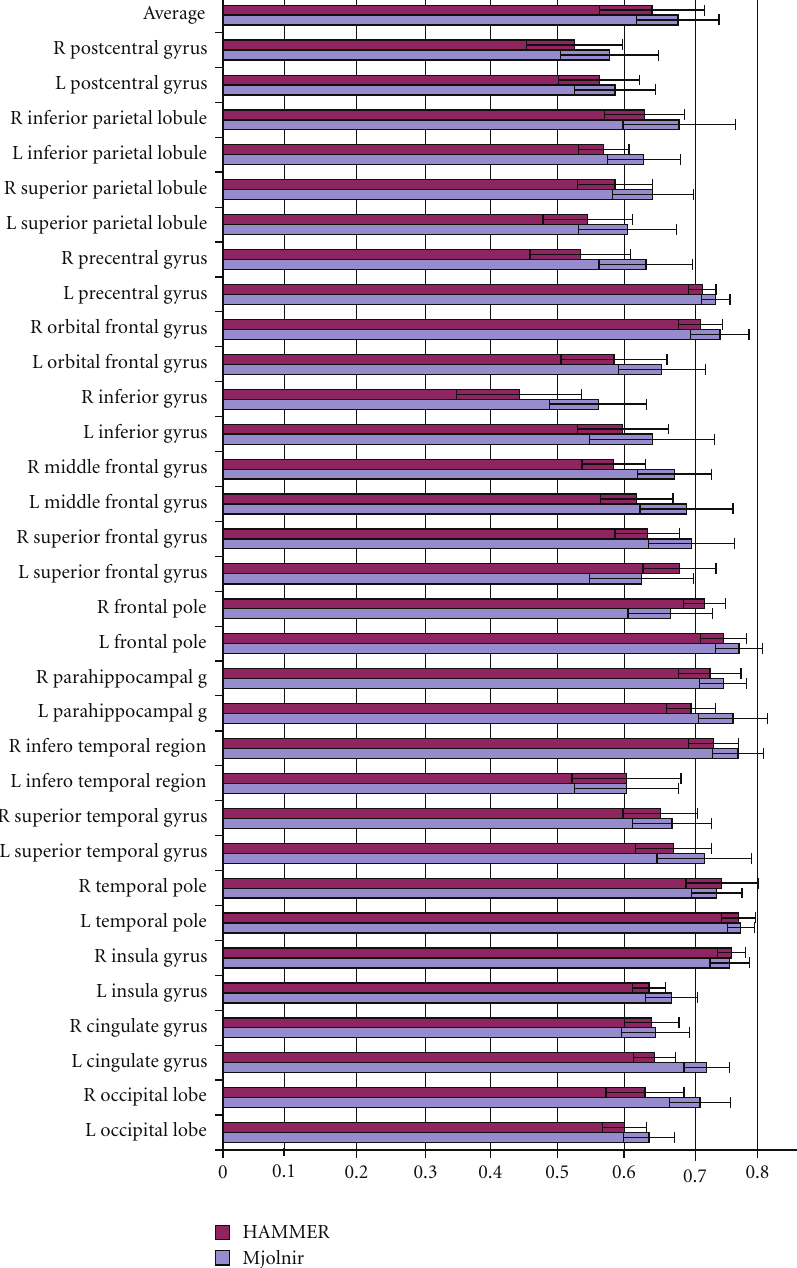
Figure 10: Average Dice coe ffi cient for di ff erent anatomical regions on the left and right hemisphere (labeled L and R) for HAMMER and Mjolnir. The top set of bars shows the average over all regions, and the error bars represent the standard deviation.